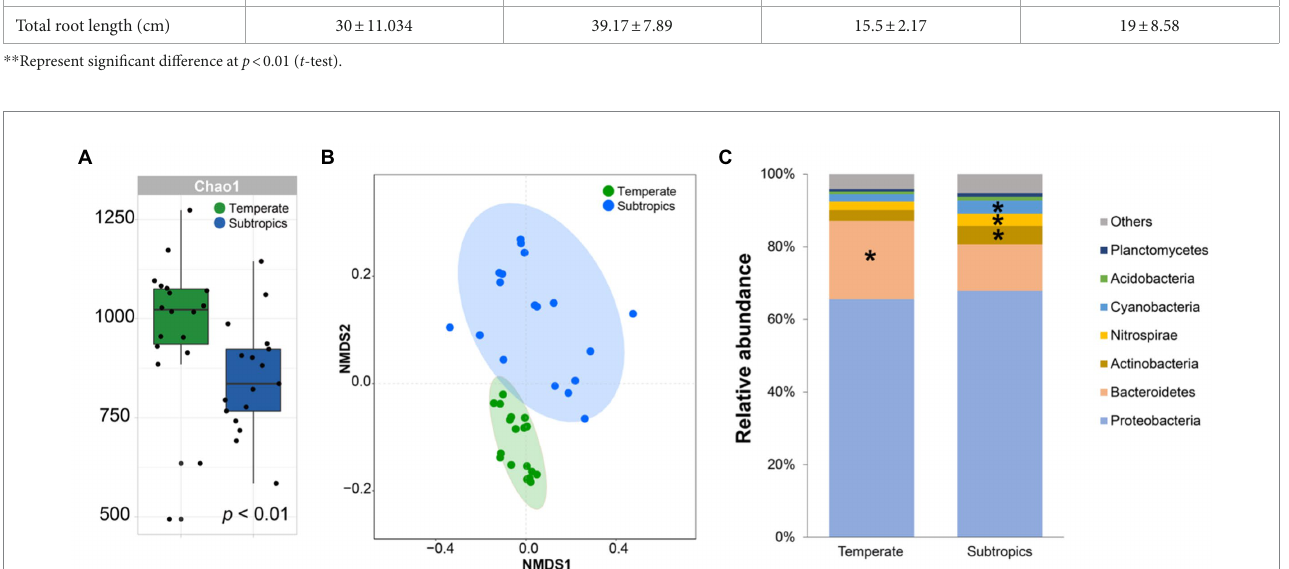
FIGURE 2 (A) Richness of bacteria in two groups; (B) NMDS analysis of bacteria; and (C) average relative abundances of bacterial phyla in two